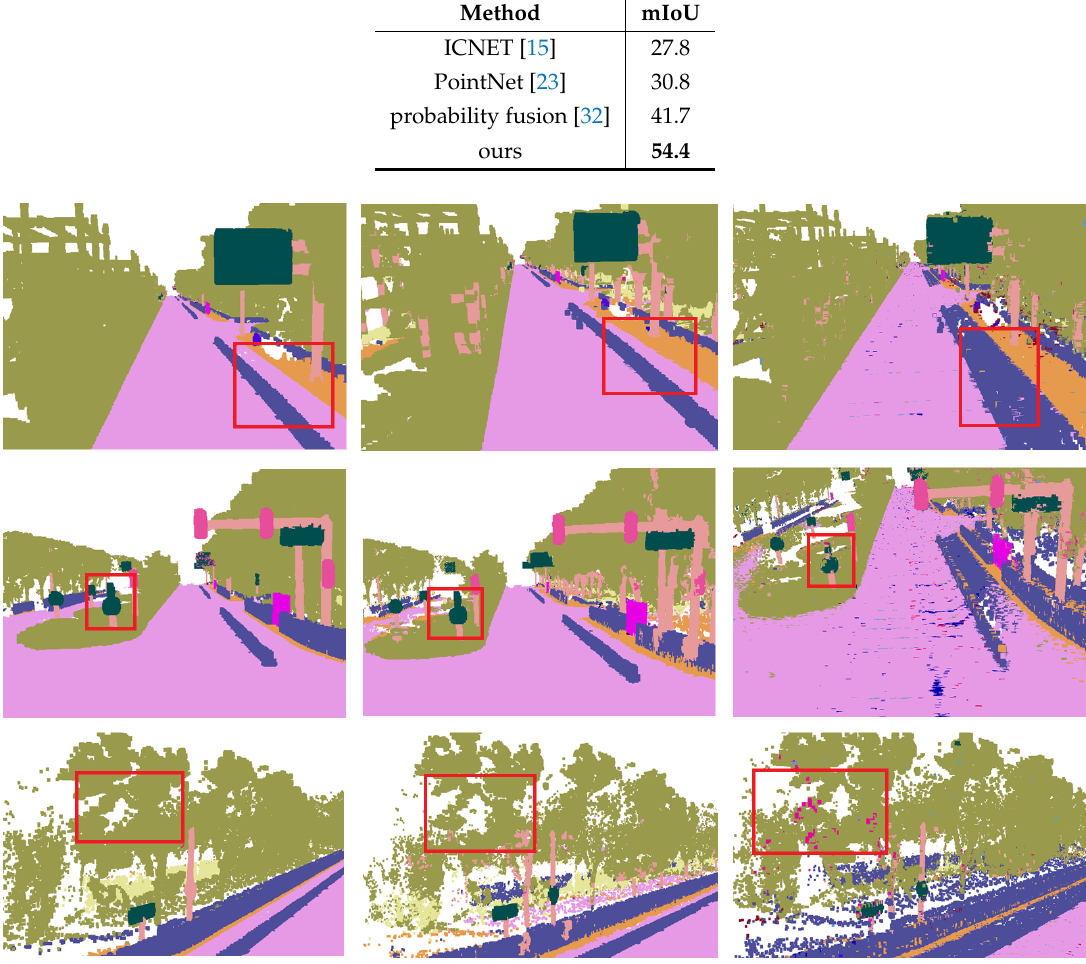
Figure 11. Visualization of Apollo dataset in detail. From the left, ground truth, Ours, [32]. The accuracy of our method in the red boxes is significantly higher than